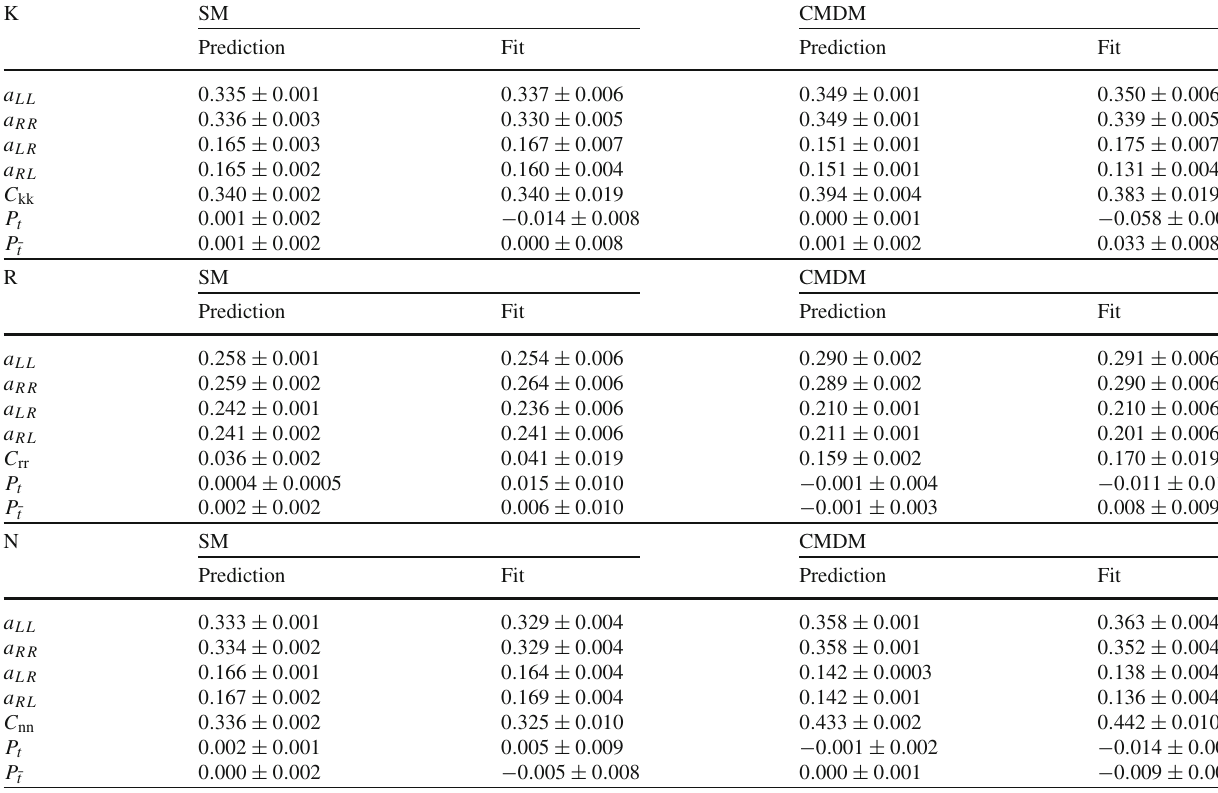
Table3 Theory predictions and best-fit values for various polarisation coefficients in the SM and CMDM data samples. For the theory predictions, the quoted uncertainty corresponds to the Monte Carlo statistical uncertainty K SM